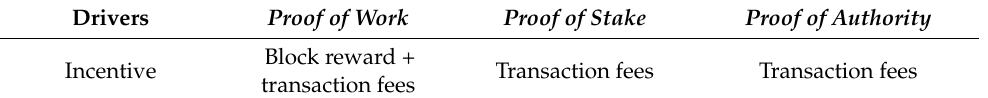
Table 1. Key characteristics of the three most common consensus mechanisms in terms of their behavioral